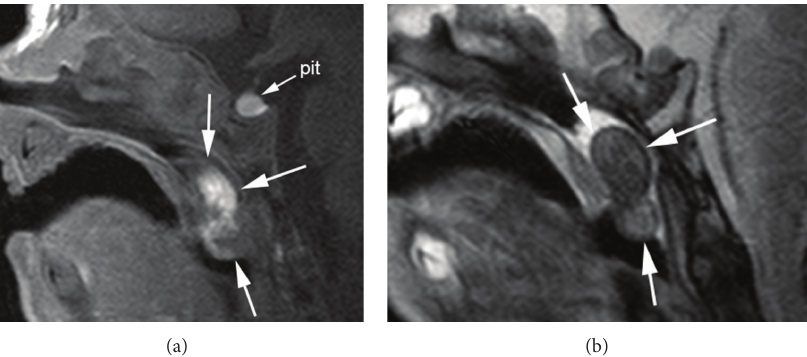
Figure 1: Sagittal short tau inversion recovery (STIR) (a) and sagittal T1-weighted (b) images of the nasopharynx show an oval, well-circum- scribed mass (arrows) that is intimately related to the posterior aspect of the soft palate, but separate from it. The lesion is predominantly hyperintense on T1-weighted images and moderately and heterogeneously hyperintense on the T2-weighted images, features suggestive of fat content. Note the normal T1-weighted hyperintensity of the anterior pituitary (pit) in a newborn, presumably related to hypertrophy of the gland due to circulating maternal hormones.